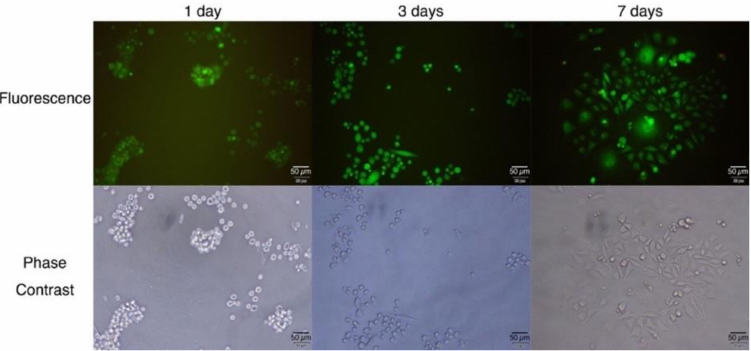
Figure 3. Fluorescence microscope images of cultured L929 fibroblast cells deposited on the surface of DNA quadruplex hydrogels. Cells with green fluorescence are alive, whereas dead cells are stained in